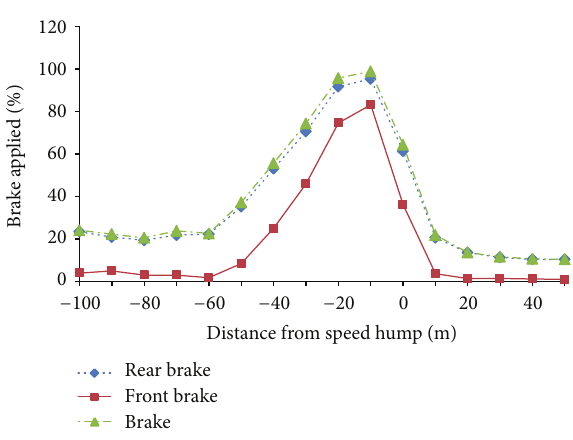
Figure 6: Brake applied profile at speed table riding.